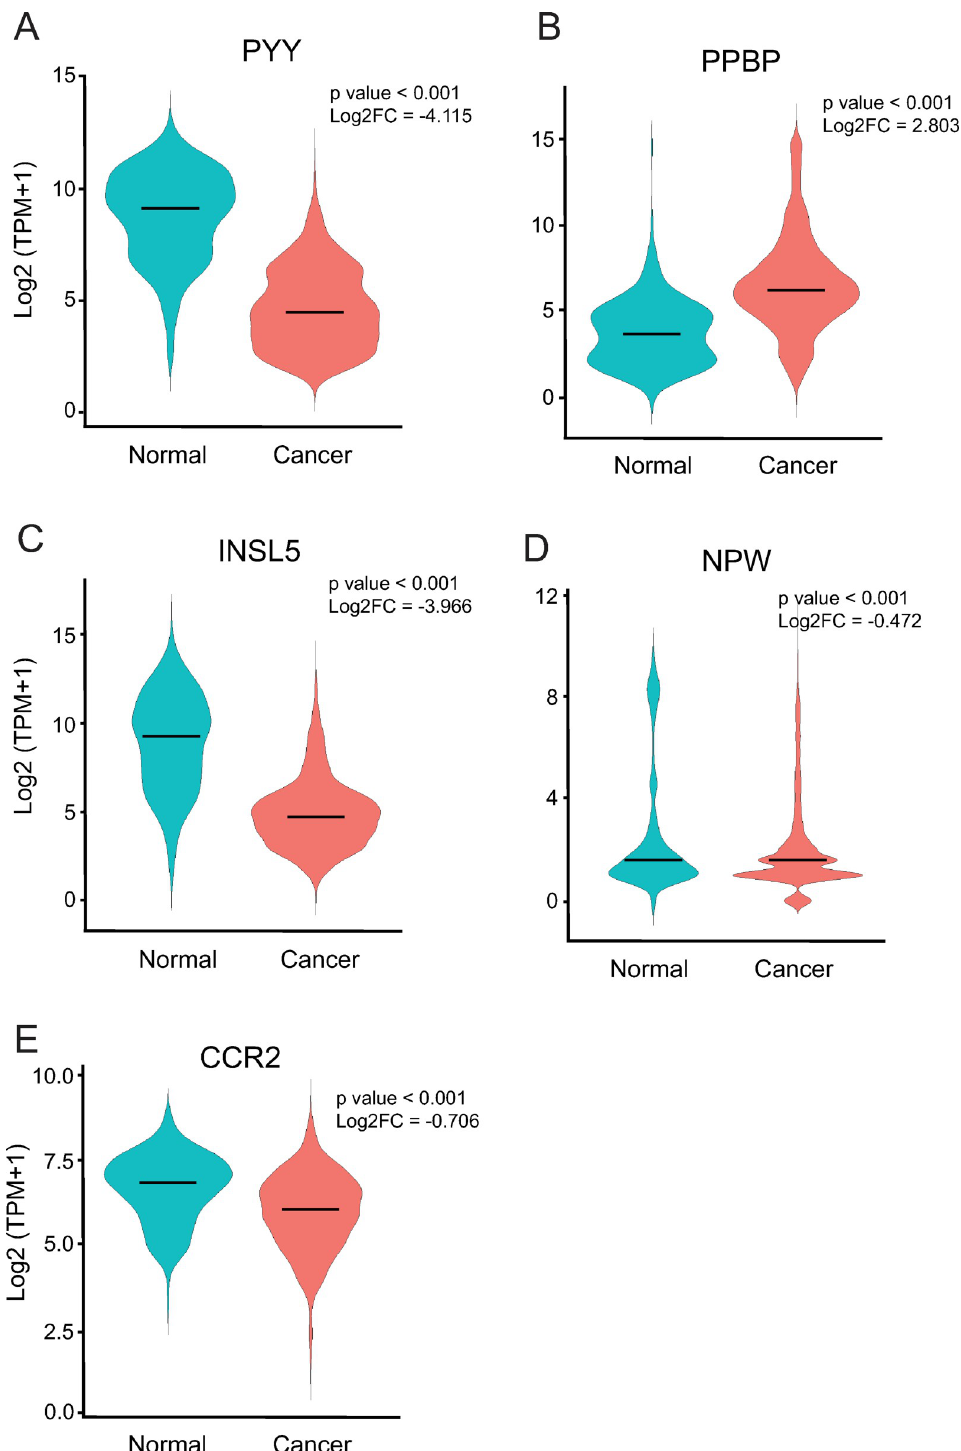
Fig 6. Hub gene expression is relevant to colon cancer. Hub genes were queried for mRNA expression using Affymetrix U133Plus2 platform microarray data from normal colon tissue (Normal) and colon cancer (Cancer) in the GEO database and the GENT2 program. Violin plots were generated using ggplot2 in R studio. The median is represented as a horizontal bar in the violin sample plot. The p value from t-tests and the Log2 fold change (Log2FC) are shown. (A) PYY, (B) PPBP, (C) INSL5, (D) NPW, and (E) CCR2.